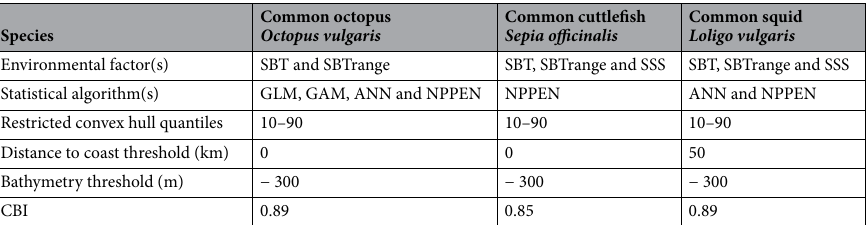
Table 2. Selected ensemble models for each cephalopod species. SBT Sea bottom temperature, SSS sea surface salinity, GLM generalised linear models, GAM generalised additive models, ANN artificial neural network, NPPEN non-parametric probabilistic ecological niche model, CBI Continuous Boyce